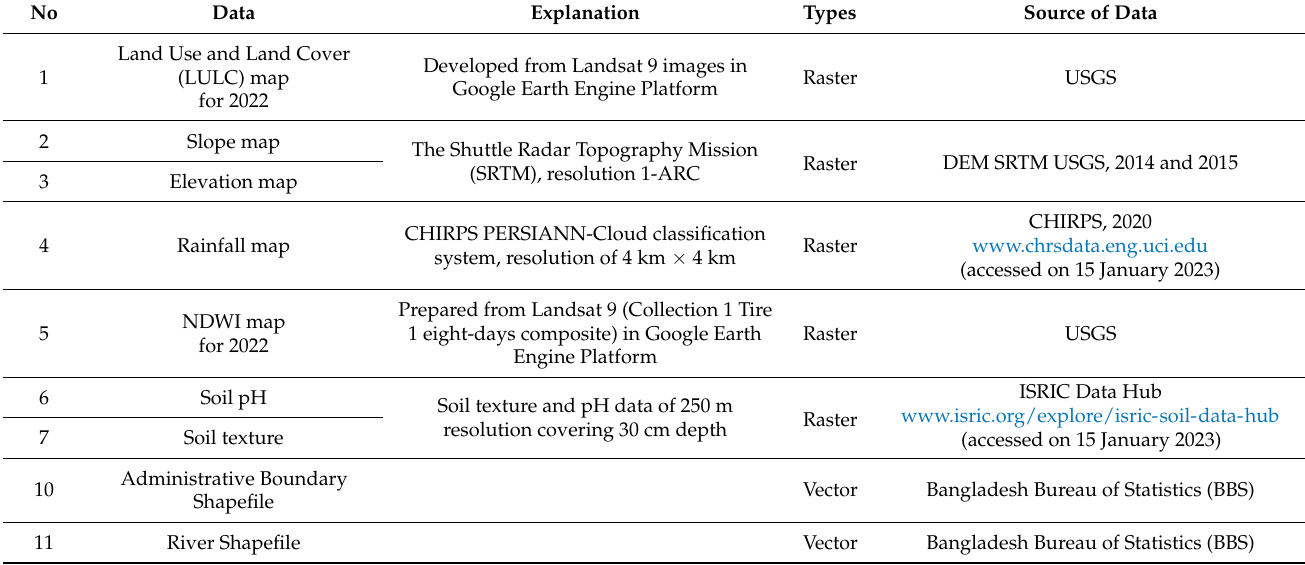
Table 2. Selected criteria, data types, data sources and their explanations for use in the study.